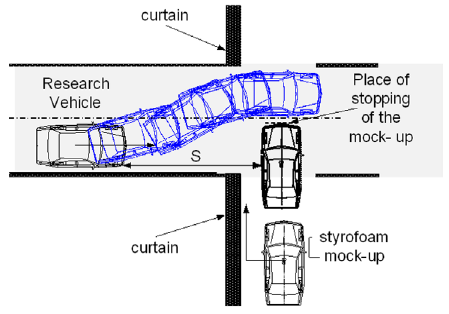
Fig. 1. Diagram of a basic scenario research